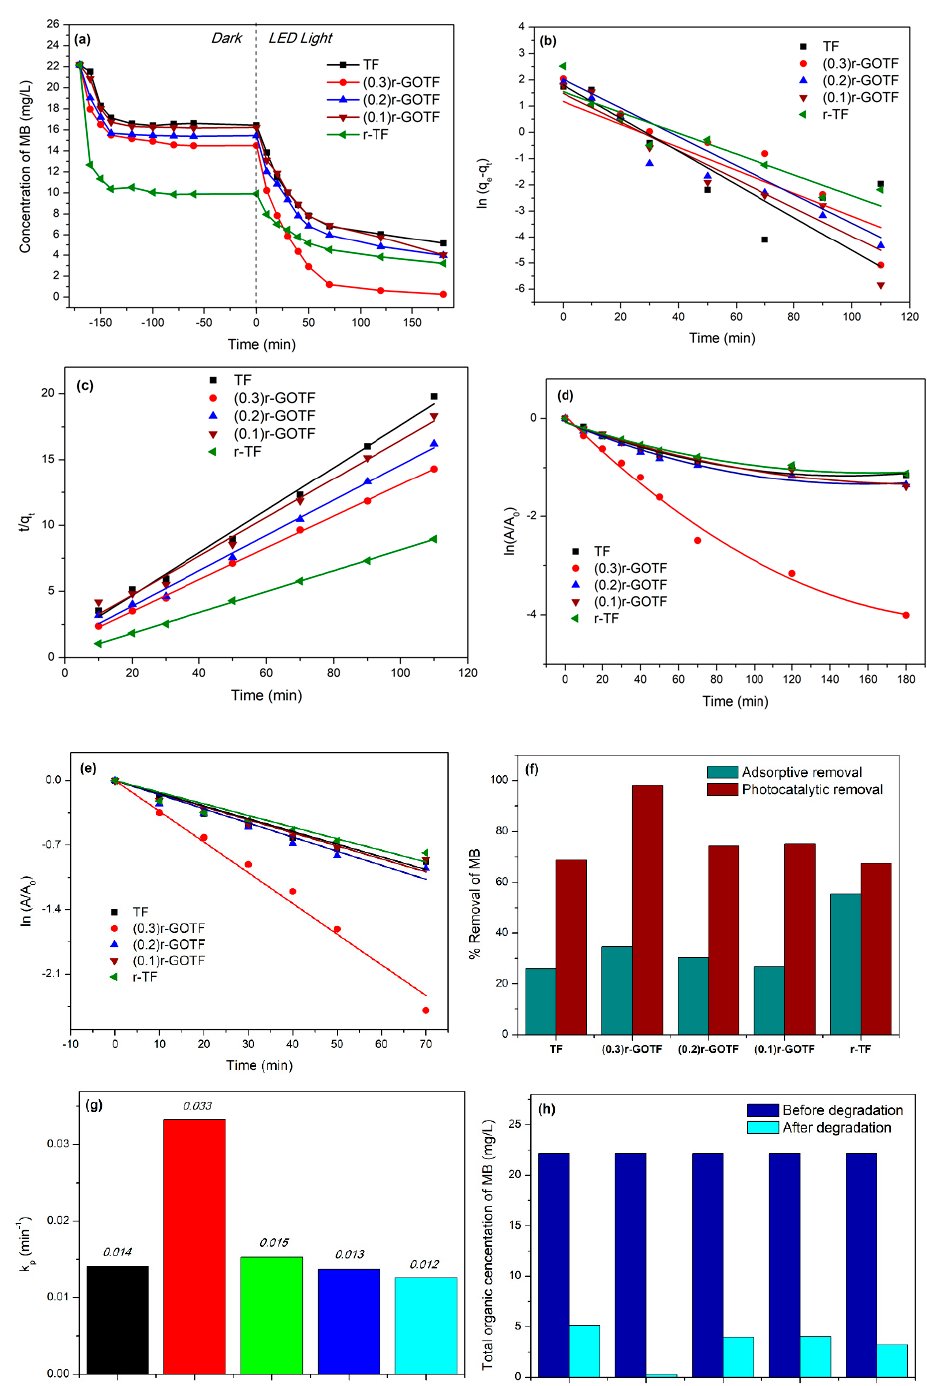
Figure 7. ( a ) Degradation of the MB concentration at different time intervals, ( b ) pseudo-first-order adsorption model of photocatalysts, ( c ) pseudo-second-order model of photocatalysts, ( d ) first-order photodegradation kinetics of MB degradation, ( e ) first-order photodegradation kinetics of MB degradation for first 70 min, ( f ) histogram of adsorptive and photocatalytic percentage removal of MB for photocatalysts, ( g ) histogram of first-order photodegradation rate constant for photocatalysts and ( h ) total organic concentration of MB in the photocatalysts system before and after degradation.